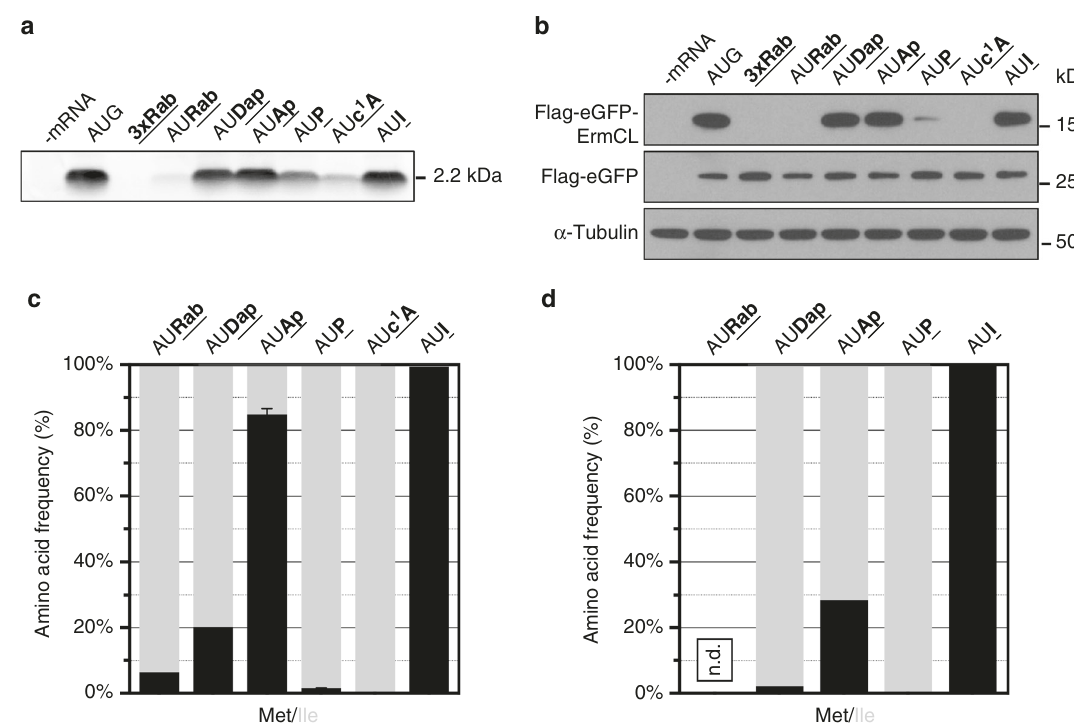
Fig. 3 Effects of modi fi ed nucleotides in the wobble position. Modi fi ed nucleotides were introduced in the wobble position and peptides were analyzed after translation in a an E. coli in vitro translation system using autoradiography or b in HEK293T cells employing western blot analysis. Puri fi ed translation products from the c E. coli system and d HEK293T cells were analyzed by mass spectrometry (n.d. not